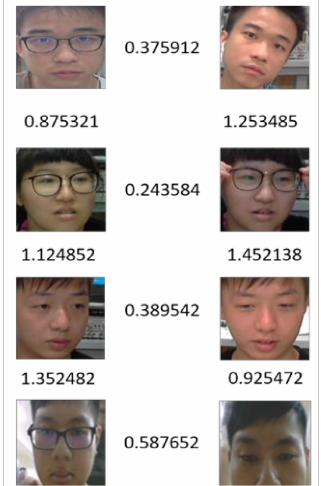
Figure 2. Face recognition using FN13 with variation in terms of lighting and postures. The numerical number between the faces represents the similarity of two images where the score ‘zero’ is considered to represent two distinct